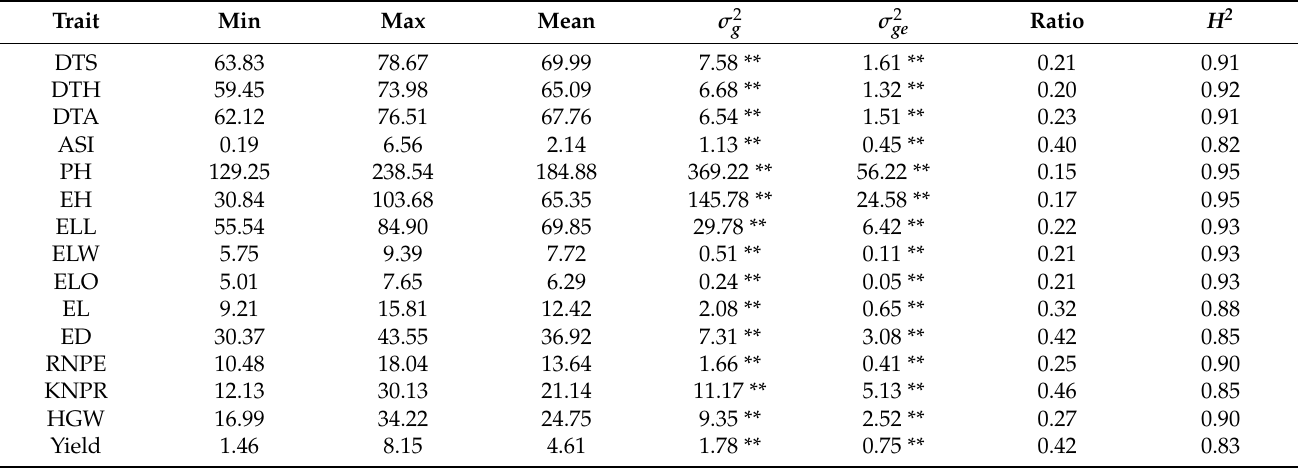
Table 1. Summary statistics for 15 traits in seven